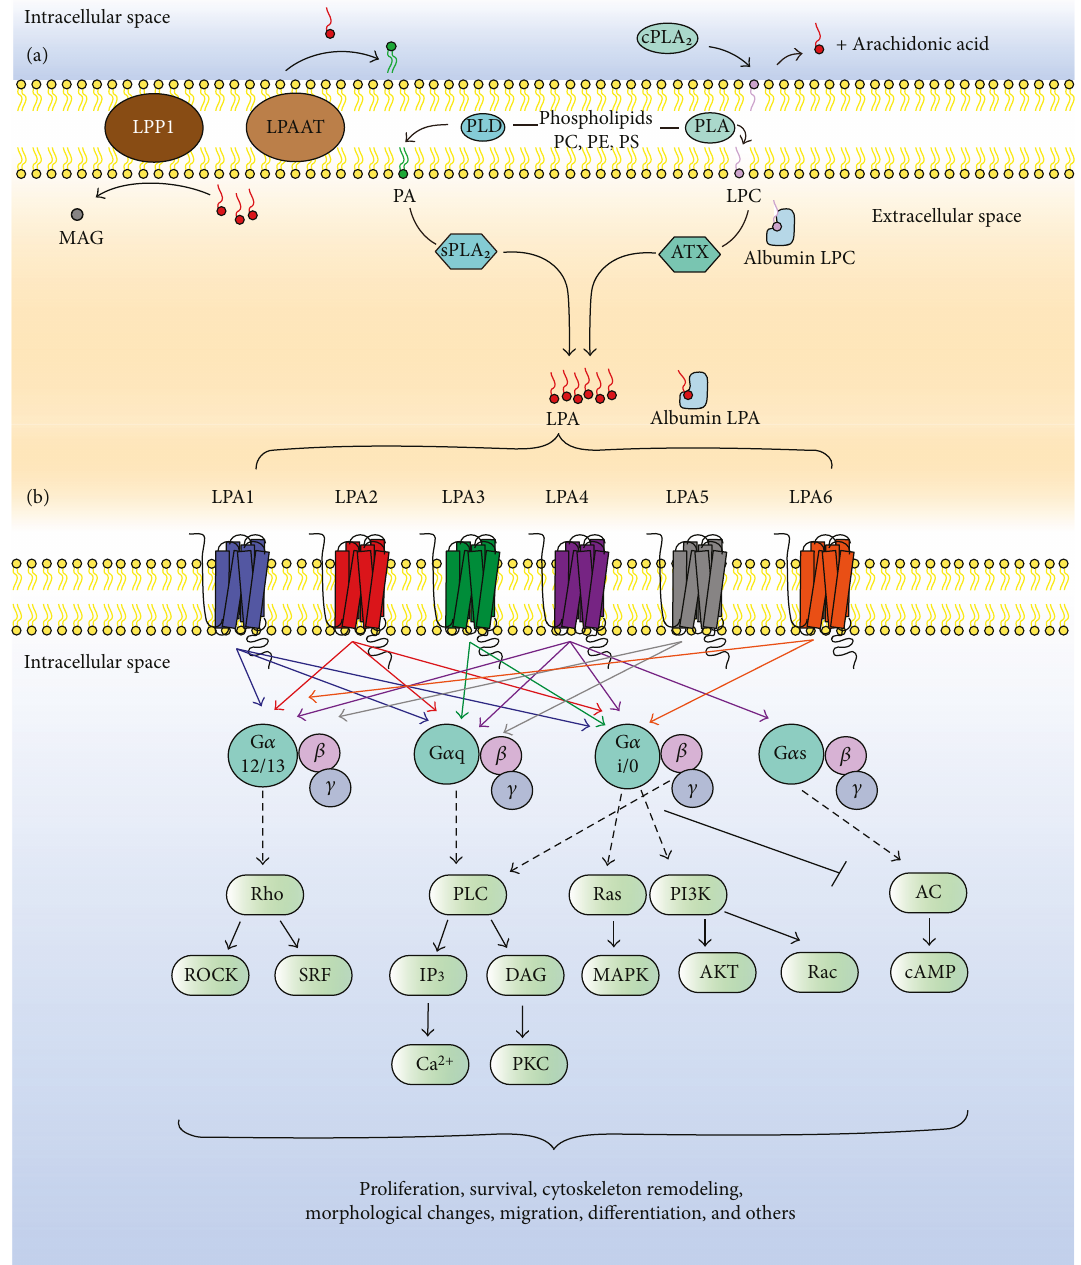
Figure 1: LPA production, metabolism, and signaling. (a) LPA species are derived from membrane phospholipids. PLA removes a fatty acid chain from PC, PE, or PS converting them into lysophospholipids. Afterwards, ATX removes the head group from LPC < LPE < LPS and produces LPA. LPC can derive from cell membrane or circulating LPC bound to albumin. LPA can also be produced intracellularly by cPLA2 from LPC producing LPA and arachidonic acid. On the other hand, PLD can remove the head group from membrane phospholipids and produce PA. Then, sPLA2 removes a fatty acid chain producing LPA. Two enzymes metabolize LPA, LPP1 in the outer lea fl et of the membrane hydrolyzes LPA into MAG, and LPAAT transfers an acyl chain to LPA in the inner lea fl et of the membrane producing PA. (b) LPA signals through at least six GPCRS (LPA ) that couple to di ff erent G α proteins to elicit activation of Rho, PLC, 1 – 6 Ras, PI3K, and adenylyl cyclase (AC) and mediate diverse processes that are cell and context dependent. This fi gure is reproduced from Blaho and Hla [29] (under the Creative Commons Attribution License/public